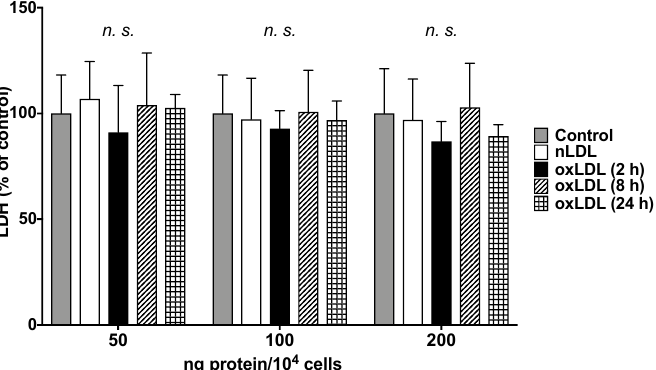
Figure 1. Cell toxicity test of C3A cells at 24 h after adding nLDL or oxLDL. Cell toxicity in the control group phosphate-buffered saline (PBS) was set as 100%. Results are expressed as mean ± standard deviation. n = 6. One-way analysis of variance (ANOVA) with Dunnett’s multiple comparisons test, n.s. not significant.